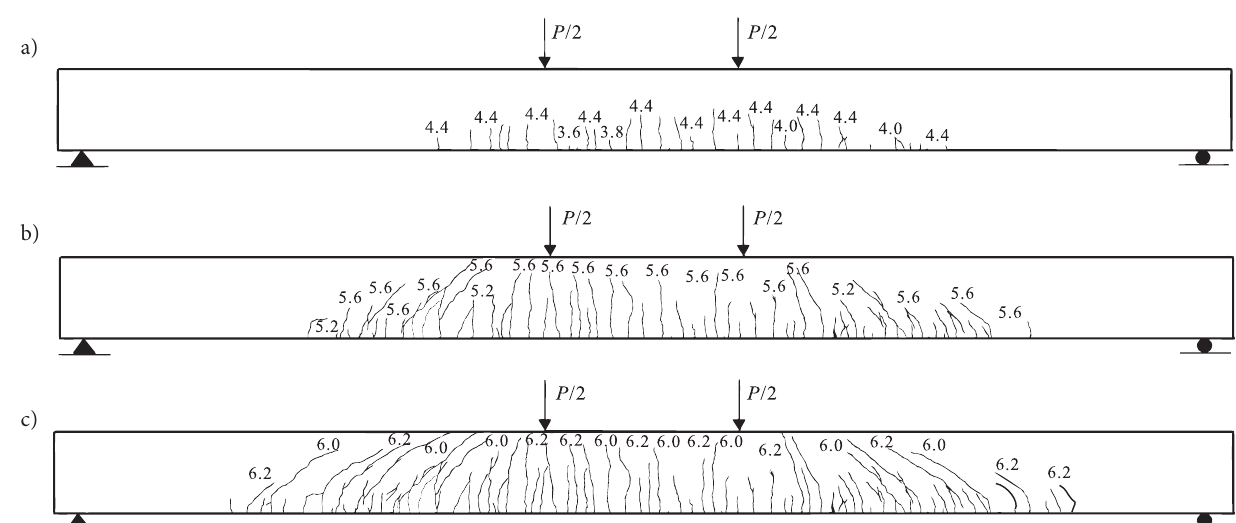
Fig. 2. Crack patterns at different loading stages: a – 0–4400 kN; b – 4400–5600 kN; c – 5600–6400 kN (Crack load: 3254